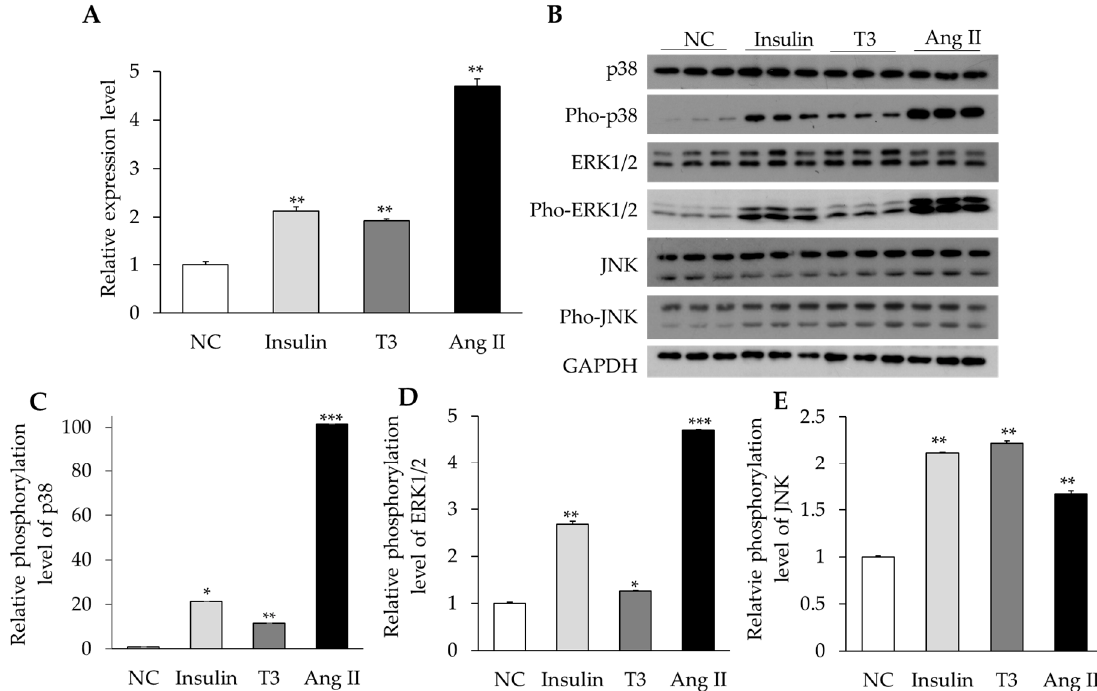
Figure 4. RBM20 transcriptional activity and activation of the mitogen-activated protein kinase (MAPK) signaling through insulin, T3, and Ang II. ( A ) Relative mRNA levels of RBM20 under different treatments; ( B ) Western blot analysis of hallmark proteins in the MAPK signaling cascade; ( C – E ) Quantification of relative phosphorylation levels of p38, ERK1/2, and JNK in comparison to their individual pho-antibodies. Glyceraldehyde-3-phosphate (GAPDH), protein loading control; NC, negative control; Mean ± SE ( n = 3), * p < 0.05, ** p < 0.01, *** p < 0.001. Statistical significance was compared between different treatments and their individual negative controls.